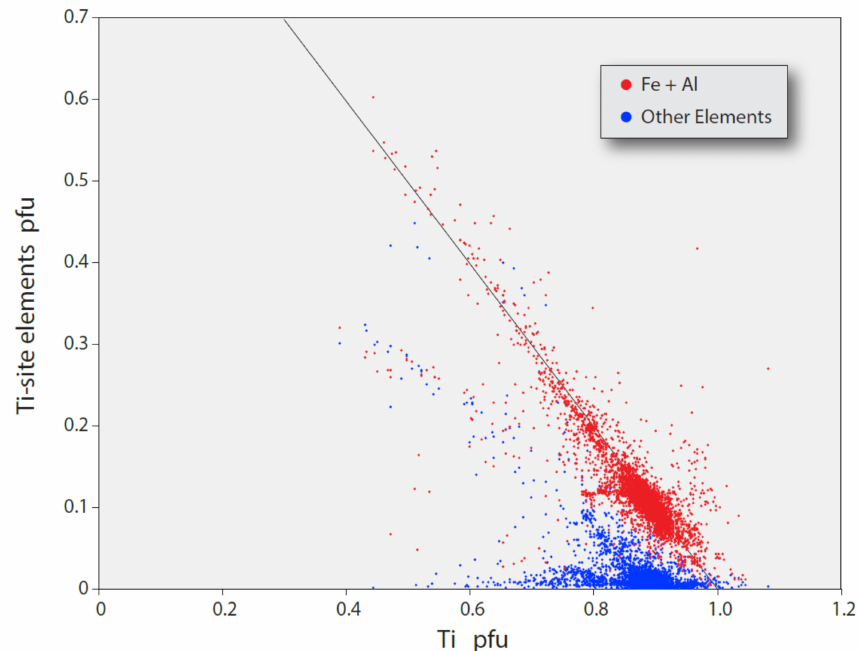
Figure 1. Ti (atoms per formula unit) in titanite plotted versus Fe + Al (red) and other elements likely to substitute into the Ti-site (blue). Fe + Al follow closely along a 1:1 substitution line, other elements that likely go into this site also trend along this line but at a shallower slope. The scatter of blue dots along the Ti axis is likely due to analytical difficulties in measuring low concentrations of these other elements. Data sources for this and other diagrams are given in Supplementary Table